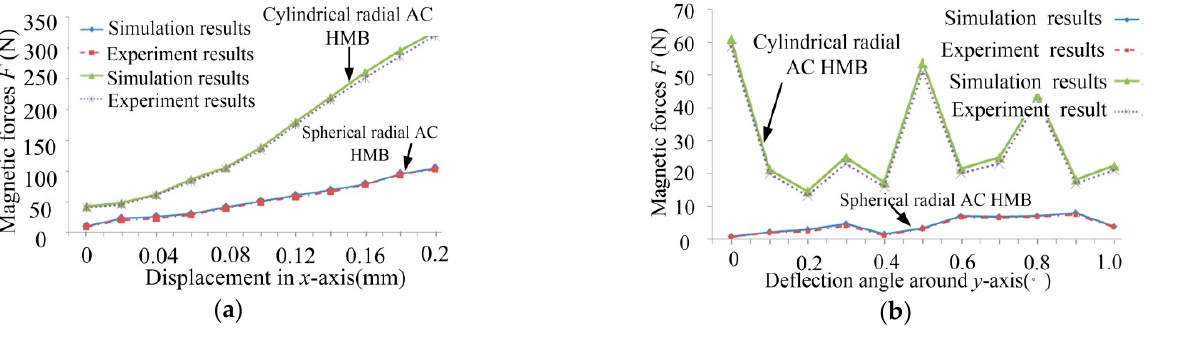
Figure 11. Stiffness comparison diagram. ( a ) Comparison of modeling results of force–displacement stiffness with experimental results. ( b ) Comparison of modeling results of force–deflection stiffness with experimental results.